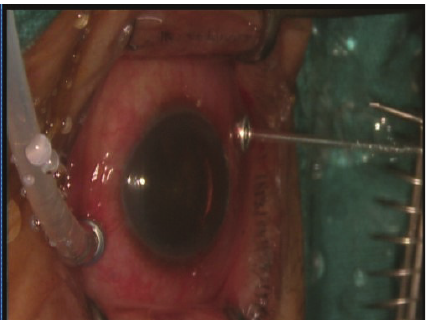
Figure 2: The passive fluid-air exchange was performed after removing the blood transfusion tube from the inferior-temporal cannula. At the same time, the patient’s head was gradually turned temporally by approximately 90 ∘